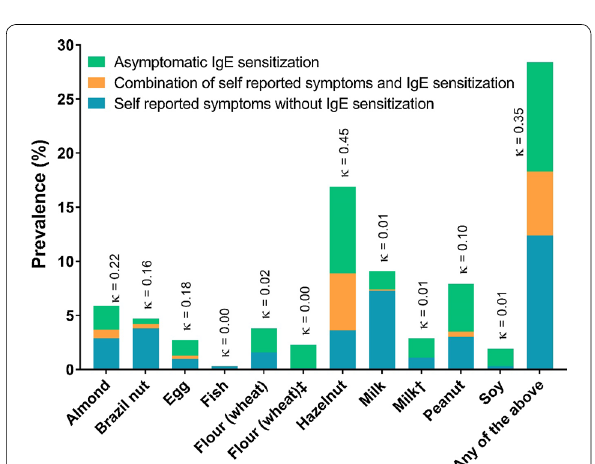
Significant p values are marked with italic ( p < 0.05) a Lactose intolerance symptoms excluded b Gluten intolerance symptoms excluded